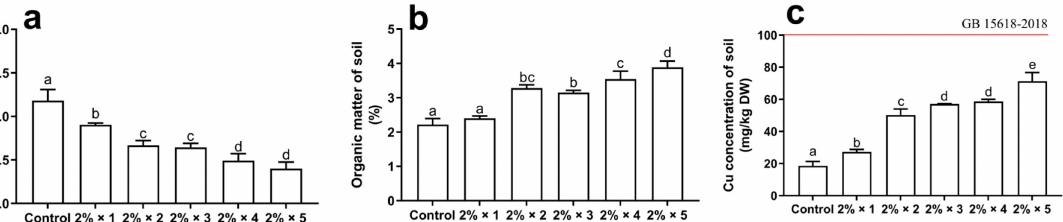
Figure 1. The pH ( a ), organic matter content ( b ) and Cu content ( c ) of the SASs (control) and application of 2% BR for one season, two seasons, three seasons, four seasons, five seasons. Red solid line indicates the concentration of soil Cu limited in GB15618-2018. Data are means ± SD of three biological replicates, with different letters in the same soil treatment indicating significant ( p < 0.05) differences according to Tukey’s